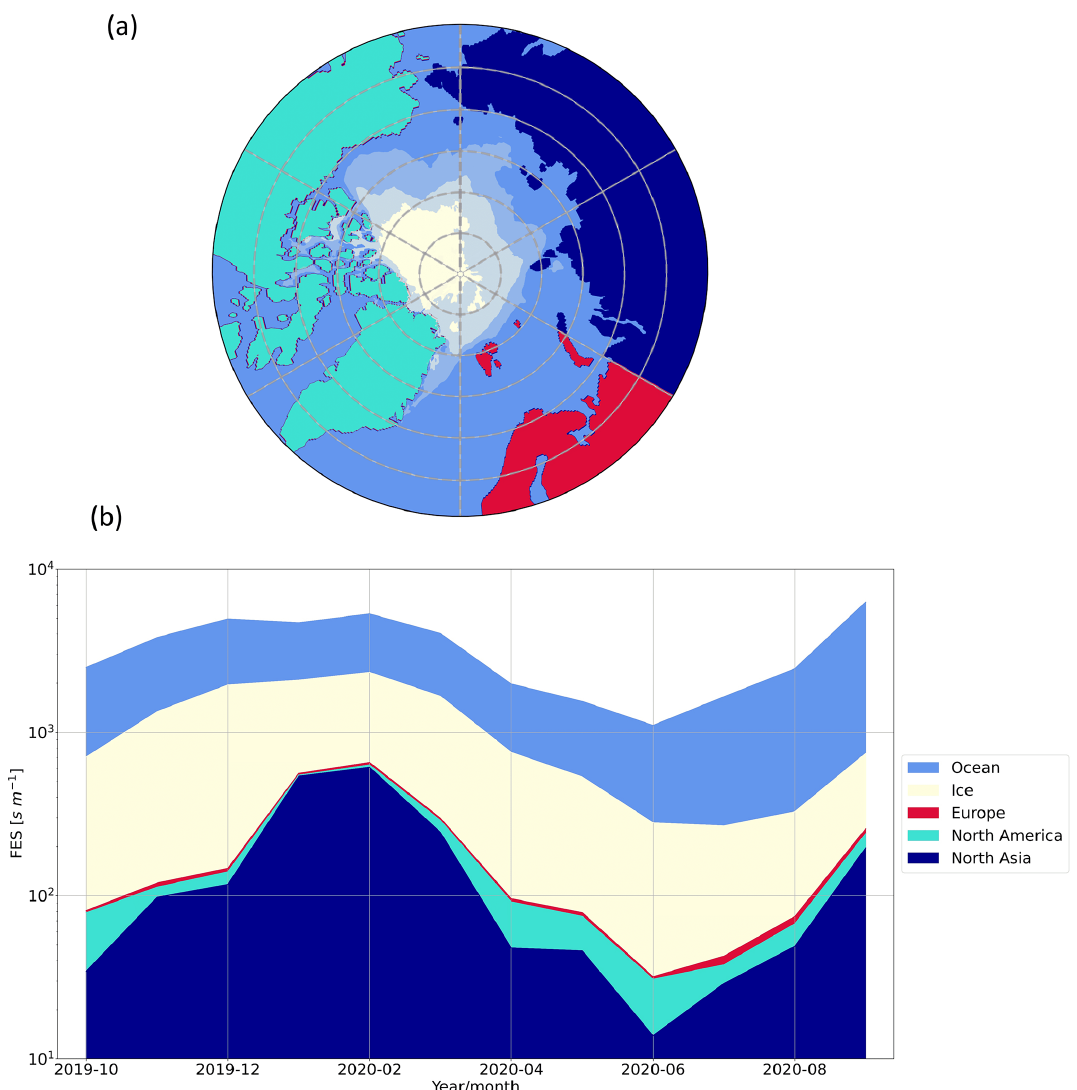
Figure 2. The seasonality of surface influence from air mass source regions using FLEXPART. A geographical mask (a) was applied to the FLEXPART air tracer data to quantify the FES associated with each geographical source region (b) . The FES was determined from the FLEXPART air tracer data within the lowest 100m of the atmosphere and was used to identify the influence of different source regions on the observed aerosol throughout the